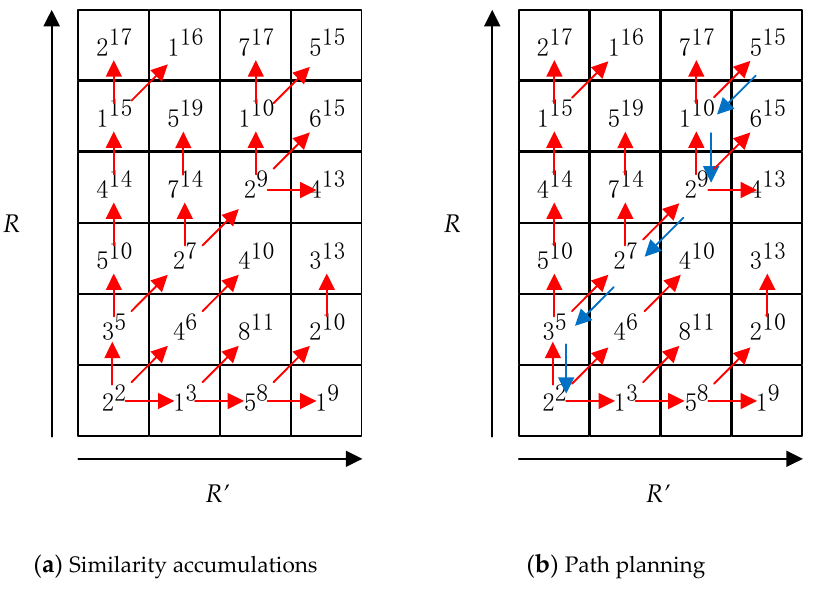
Figure 7. The shortest path planning.